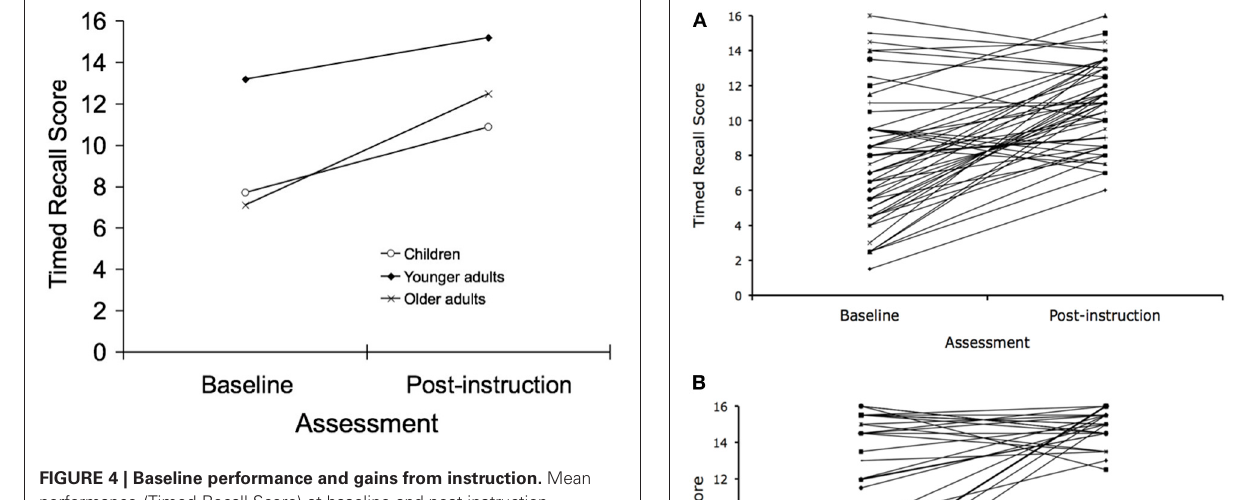
starting model, (cid:3) χ 2 = 40 . 79, df = 2, p < 0 . 001. Univariate tests